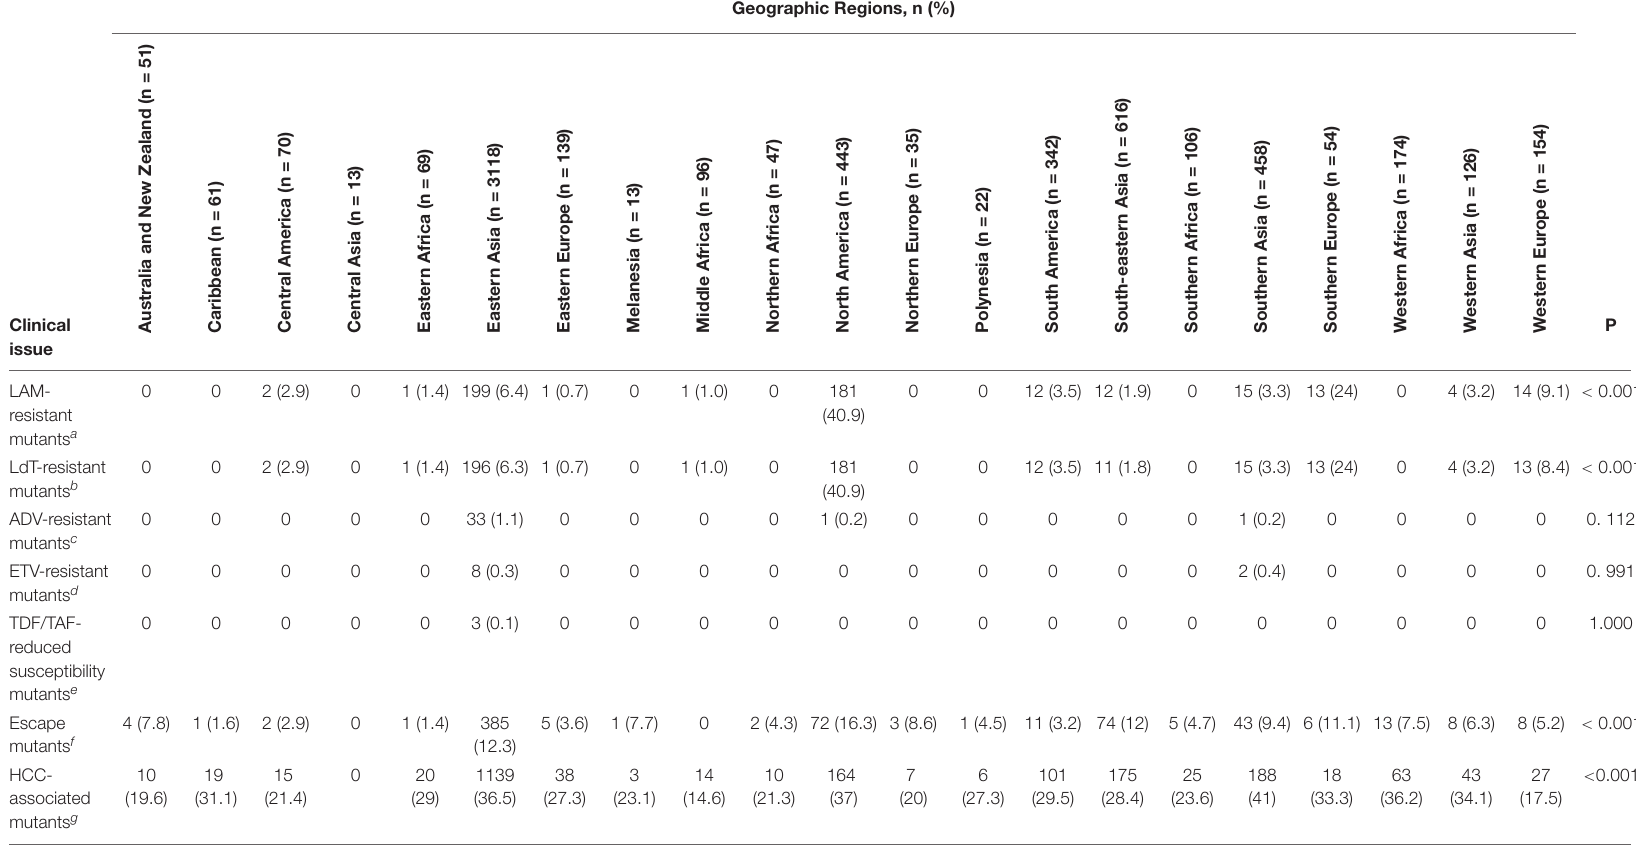
Geographic Regions, n